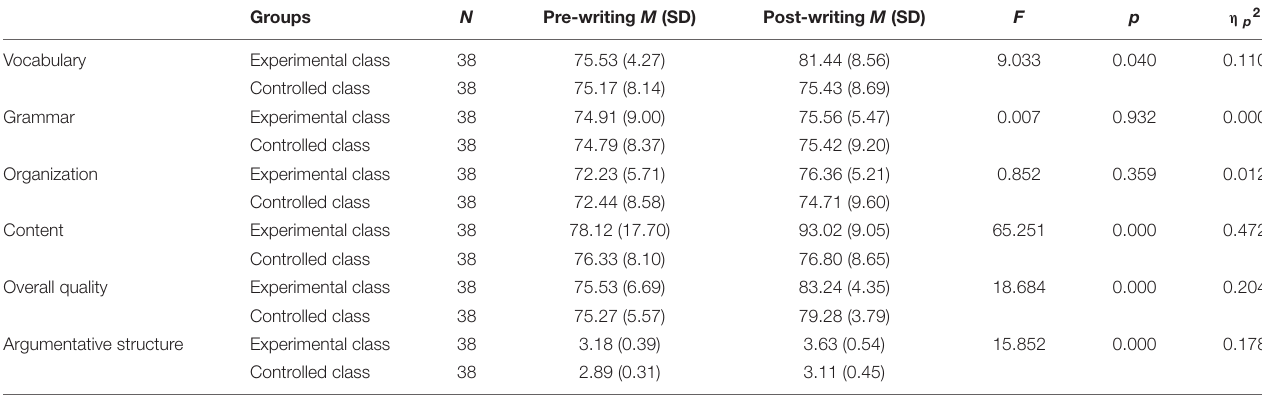
TABLE 3 | One-way ANCOVA results of the two classes’ essay